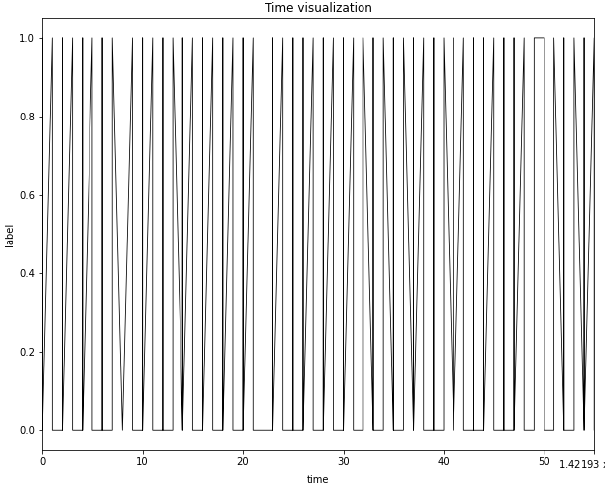
Figure 4. Time visualization image of the UNSW-NB15 dataset.